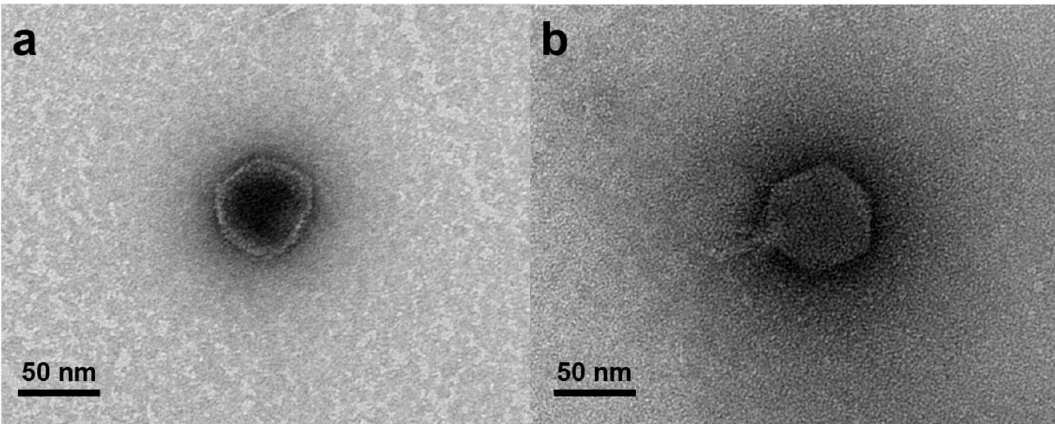
Figure 1. Electron micrograph of isolated phages, pVco-5 (a) and pVco-7 (b).